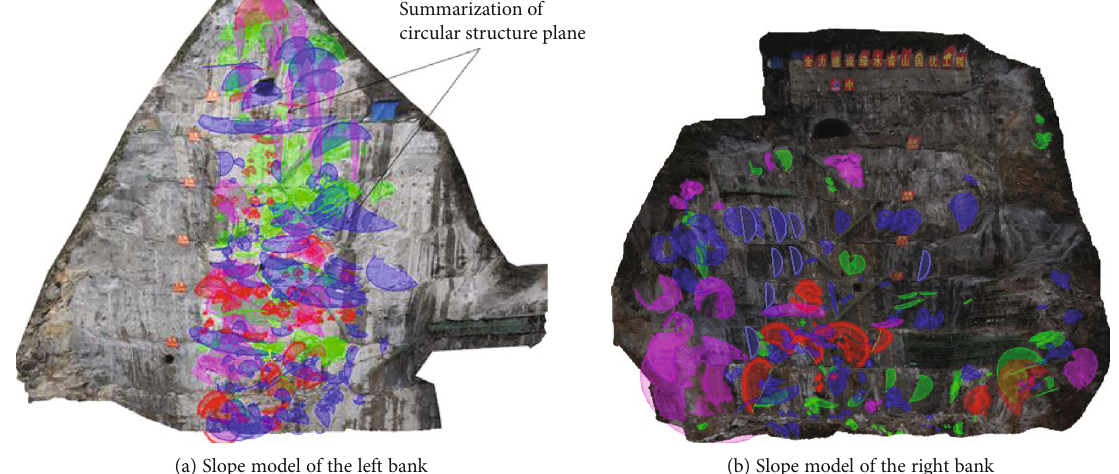
Figure 4: 3D digital model and data extraction of fracture outcrop cataloging in 3DM software. Table 1: Principal permeability coe ffi cient of slope K